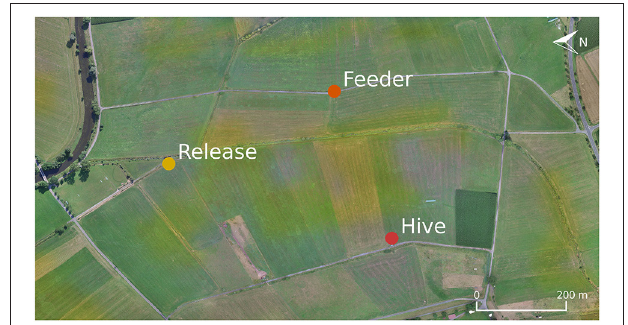
FIGURE 1 | Map of the field site for the behavioral experiments. For the homing experiment, honey bees from the hive (Red) where trained to forage at the indicated feeder location (Orange). Individuals caught at this site were attached to the quadcopter and transported to the release site